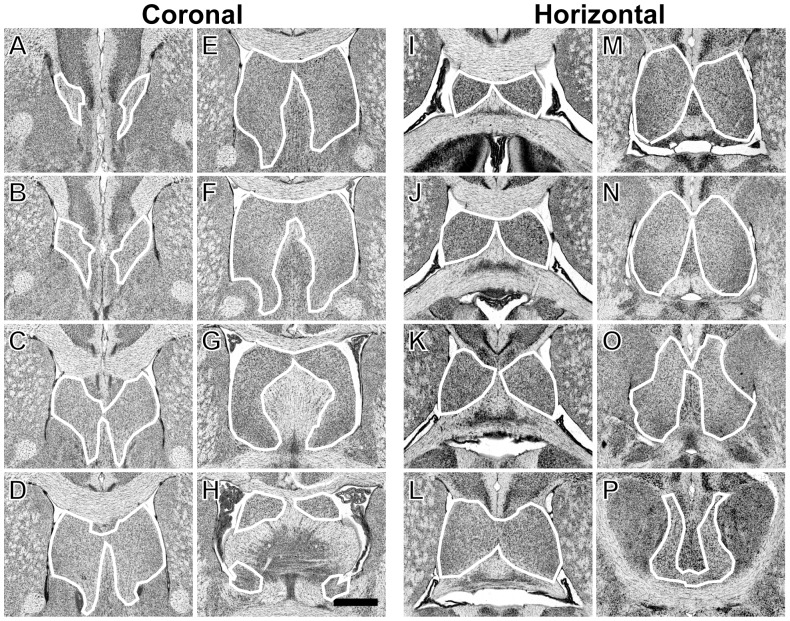
The parameters for the boundaries of the LS in coronal (A-H) and horizontal sections (I–P).In the coronal slides, LS begins just under the tenia tecta, forming a light, thin grainy tissue bordered by white matter (A). It then expands dorsally to form two large upturned triangular regions separated in the middle by the medial septum and bordered on the distal ends by the third ventricle (B–D). The ventral border of the LS is the line between the two Major Island of Calleja ventricles, or the line between the two nuclei of the anterior commissure olfactory limb if the former were not present in the coronal section. Moving caudally, the LS appears more dorsal and is bordered by the fornix, with a clear difference in the tissue between the lateral septum, the septofimbrial region (a darker region within the fornix included in the measurements), and the surrounding lighter regions of the fornix and darker regions of the stria terminalis (E,F). In the caudal-most sections, the third ventricle separates the dorsal end of the LS as well as the fornix, and the remaining LS is easily distinguished from surrounding tissue (G,H). In the horizontal slides, the lateral septum is easily distinguished early on as two rounded bodes of dense grey matter between the curved arches of the cingulated gyrus (I–K). These two rounded bodies gradually grow in size and eventually meet just rostral to the darker matter of the medial septum and the less dense white matter of the fornix (L). Moving ventrally through the horizontal plane, the two rounded regions of the LS continue to grow outwards, and meet at their lateral anterior borders with the darker coarse grey matter of the nucleus accumbens (N), which goes on to surround the LS on all but the caudal border, which is marked by the white arch of the anterior commissure (P). Dorsal to the anterior commissure (O), the caudal borders of the LS arc from the caudal end of the third ventricle to the rounded white matter of the fornix.